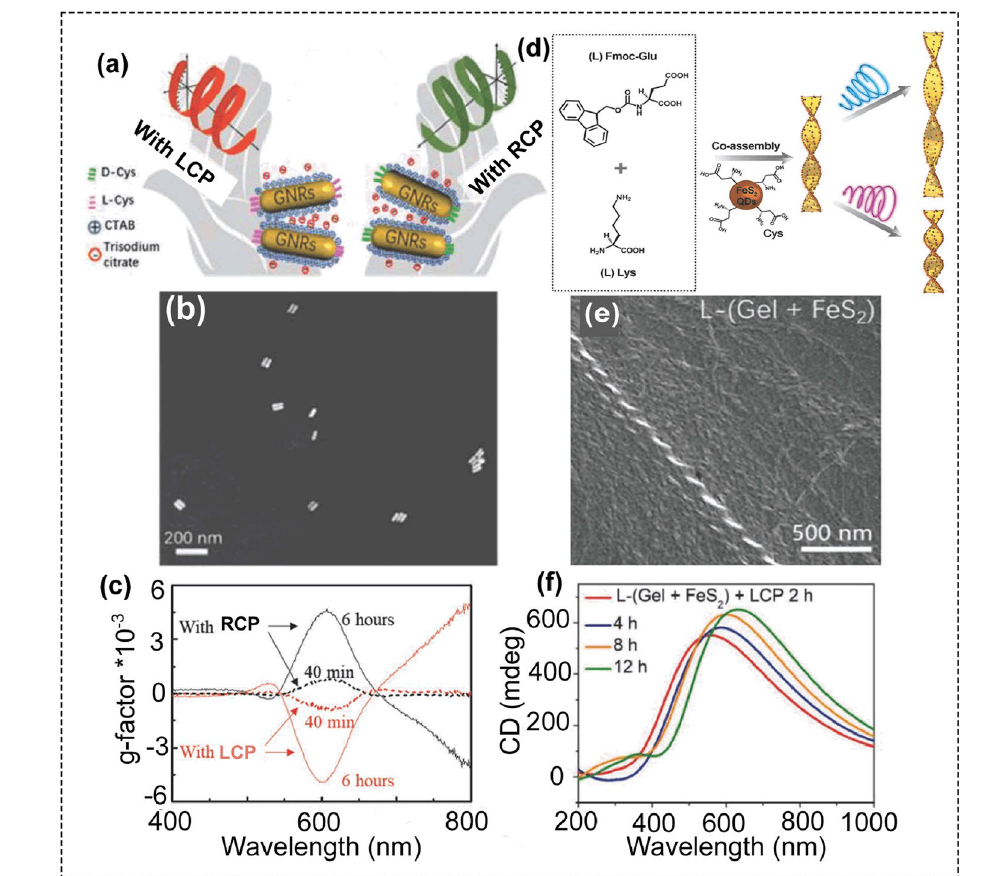
Fig. 5 a – c Chiral GNR dimers and the asymmetric interactions with CPL. a Schematic illustrating the chiral GNR dimers with opposite hand- edness under illumination of CPL. b Typical SEM image of the GNR dimers. c g-factor spectra acquired from the GNR dimers under LCP or RCP light illuminations for 40 min (dashed lines) and 6 h (solid lines), respectively. LCP or RCP light was irradiated from a diode laser with a wavelength of 633 nm and a power density in the range of 50–90 mW cm −2 . (reproduced with permission from Ref. [3]. Copyright 2019, WILEY–VCH GmbH). d Illustration of the co-gel formation and its CPL responsiveness. e SEM image of the L-(Gel + FeS 2 . f CD spectra of the L-(Gel +